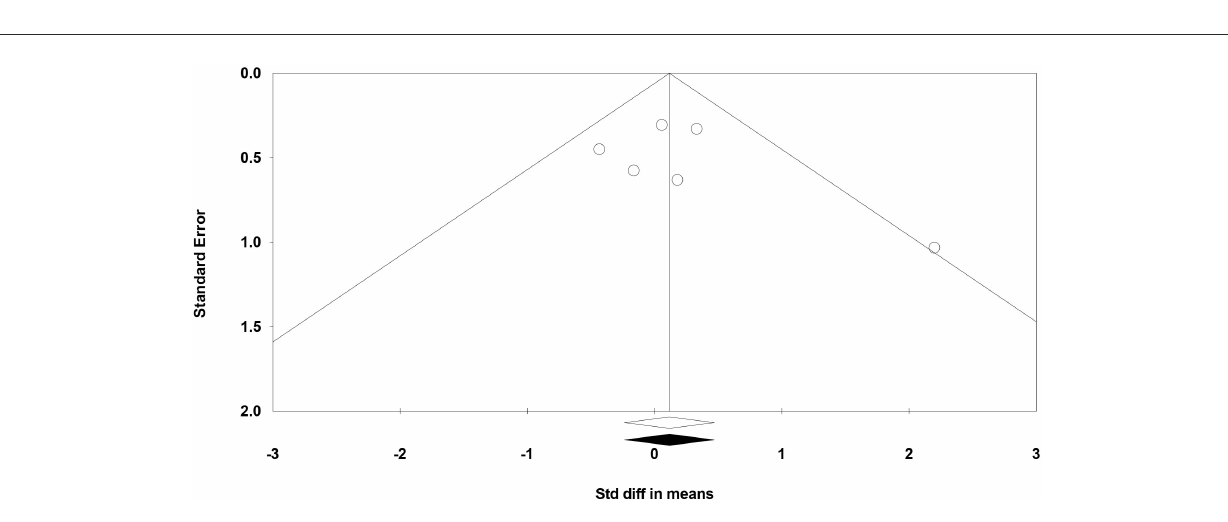
Ventral capsule/ventral striatum